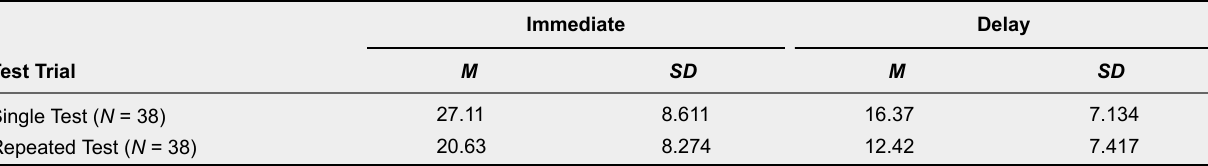
Means and Standard Deviations of the Number of Words (Total = 40) Recalled in Immediate and Delayed Final Recall by Test Trial (N = 76) Immediate Delay Test Trial M SD M SD Single Test ( N = 38) 27.11 8.611 16.37 7.134 Repeated Test ( N = 38) 20.63 8.274